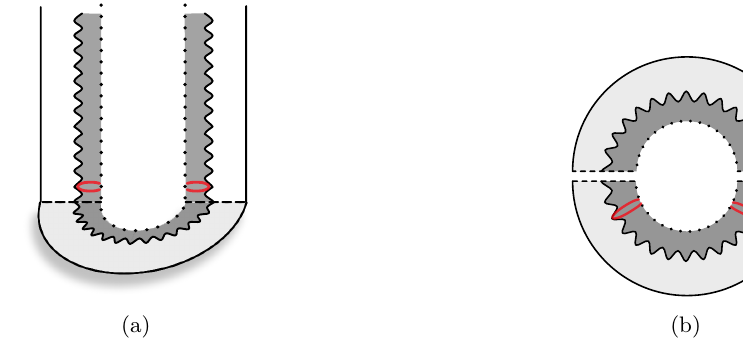
Figure 6 . The Bulk TFD State . The infinite cylinder geometry of the sine-Liouville background has the topology of an annulus (right). The linear dilaton implies that the string coupling vanishes at one asymptotic boundary and diverges at the other, represented by the solid and dotted circles. When the annulus is halved and glued to the Lorentzian continuation, it prepares the TFD state in two disconnected copies of flat linear-dilaton spacetime (left). The state prepared by halving the dual EBTZ background is similar but with an additional circle suppressed. Also pictured is the embedding of a string worldsheet with a pair of Euclidean time winding operator insertions from the sine-Liouville potential. The image of the worldsheet wraps the Euclidean time circle, extending out from the dotted strong-coupling boundary toward finite coupling, before folding back on itself and falling back to strong coupling. When the worldsheet is sliced in angular quantization, each spatial slice is then mapped to a folded string, shown in red, that comes in and out of the strong-coupling region. The full sine-Liouville potential adds a condensate of such folded strings on top of the disconnected union of linear-dilaton × time backgrounds. Expanding the condensate, one obtains an EPR description of a string in a superposition of entangled disconnected spacetimes, dual to string theory in the connected black